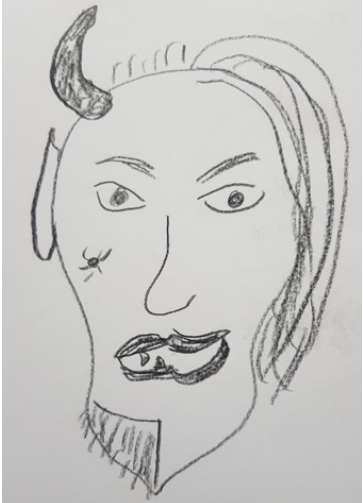
Figure 4. FC29’s perception of PD.